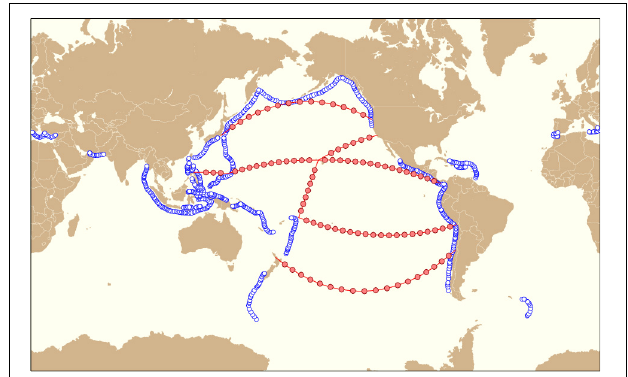
FIGURE 9 | Hypothetical cable routes and SMART repeater locations (red dots) used in tsunami simulations. Also shown are potential trench axis earthquake epicenters (blue circles). Permission obtained for use of